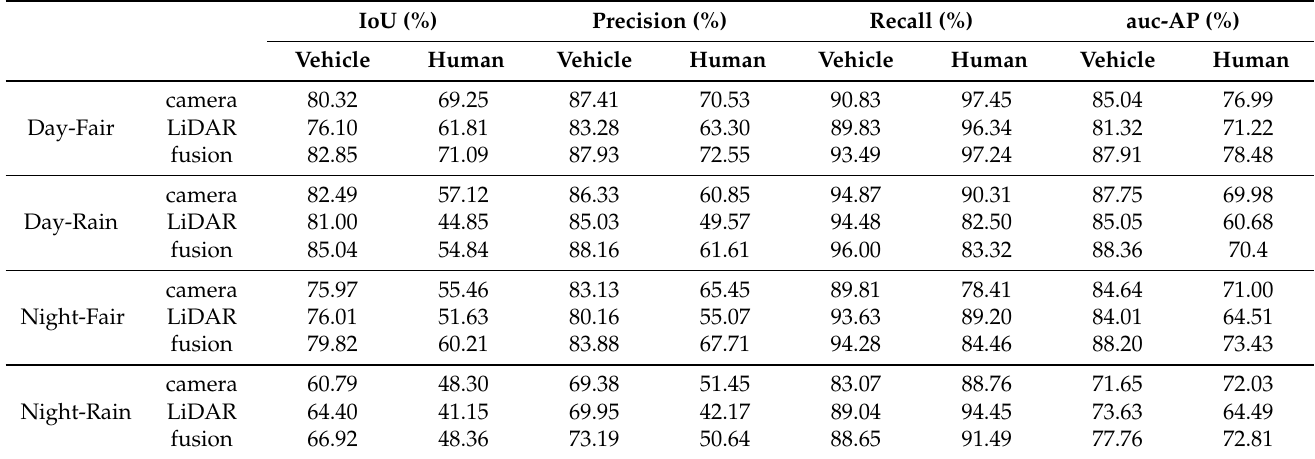
Table 7. Performance of the semi-supervised transfer learning iseAuto models.